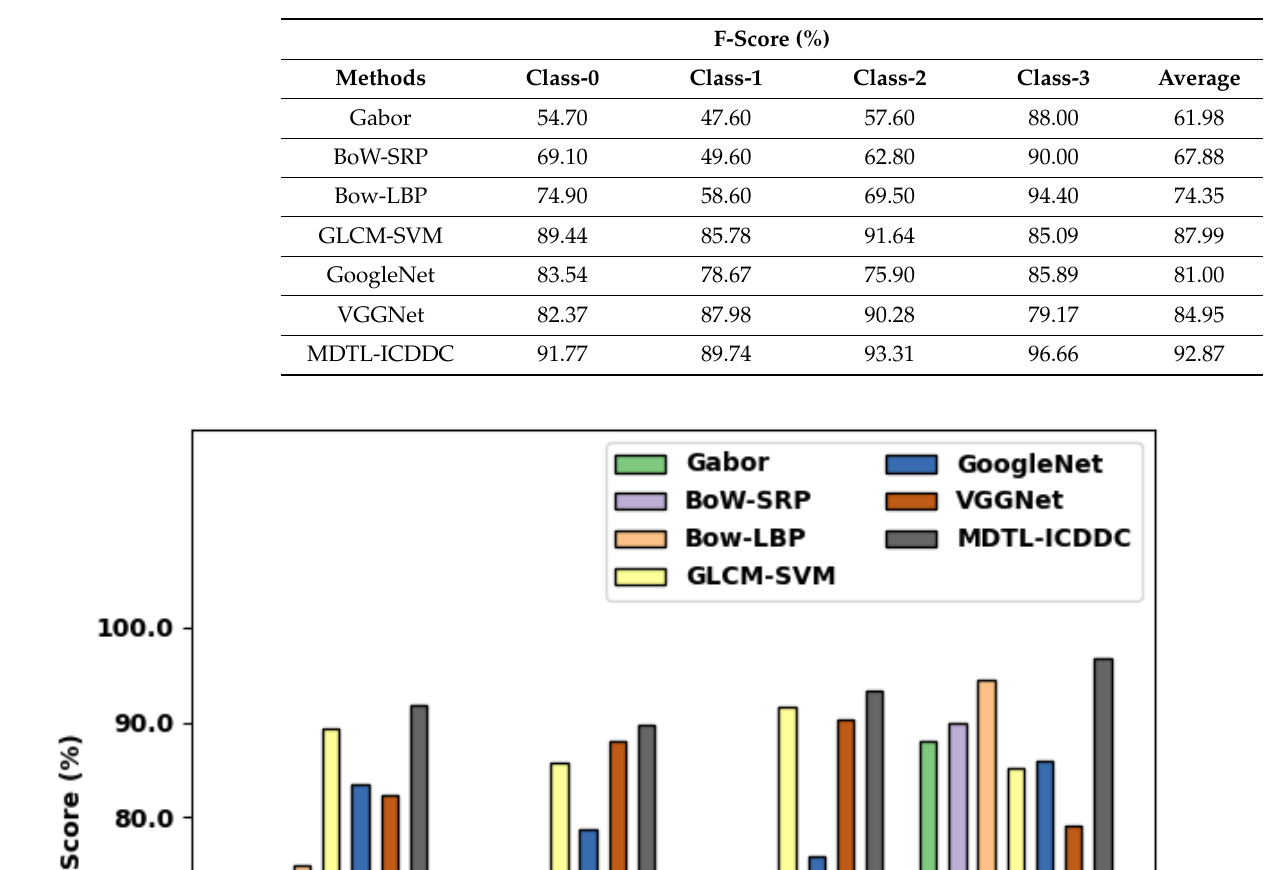
Table 6. F-score analysis of MDTL-ICDDC technique with existing algorithms under various classes.